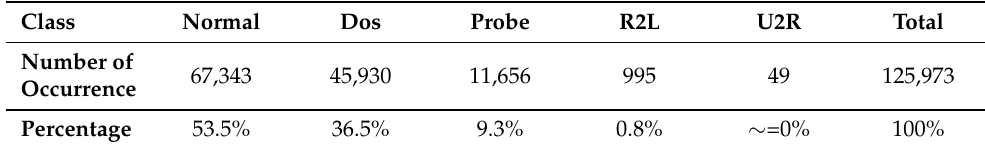
Table 3. Summary of the NSL-KDD data